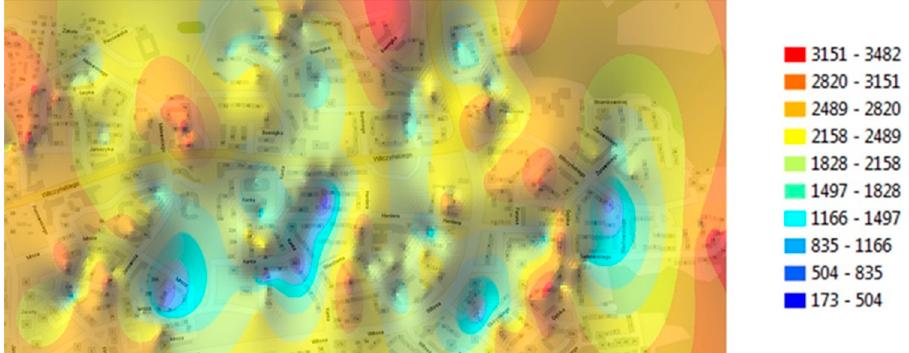
Figure 7. An analysis of the range of fluctuations in average property prices between 2005 (lowest values) and 2007 (highest values). Source: own elaboration.